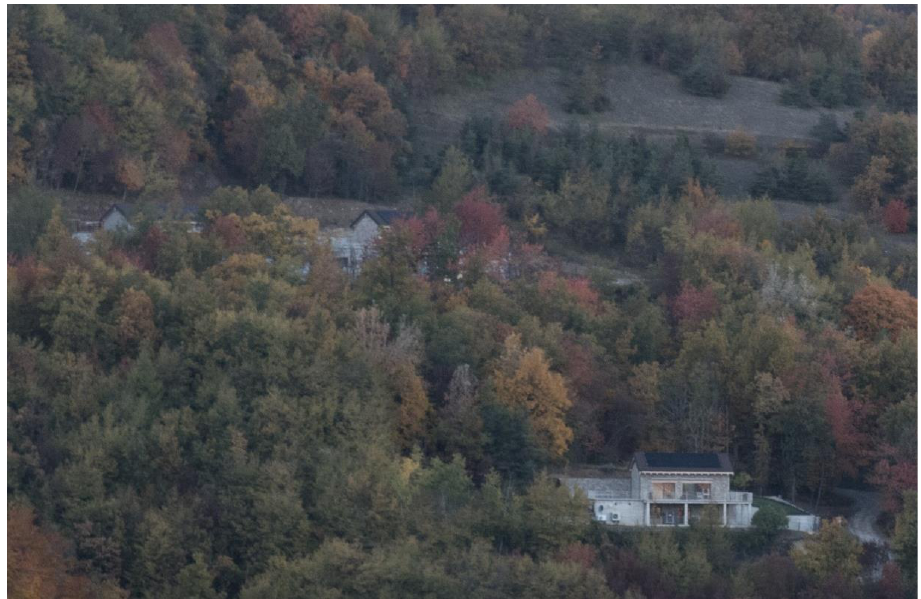
Figure 8. A new touristic development by foreign people renting to foreign tourists, non-respectful of traditional building types nor interacting with local